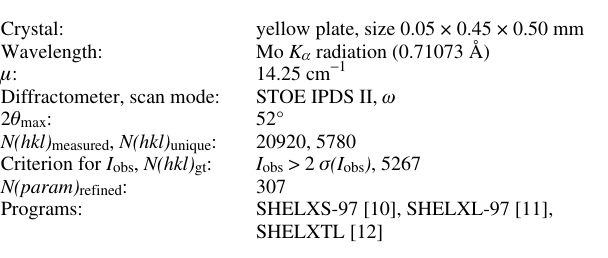
Table 1. Data collection and